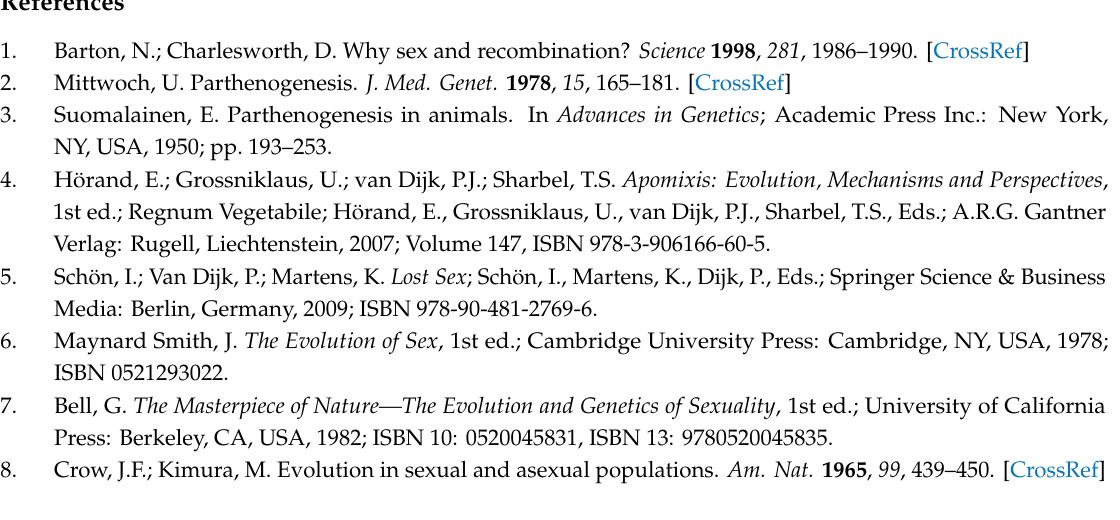
Figure S1: Images of ovule staging (I, II, III, IV). The bar represents 100 µ m, Figure S2: Change in expression patter according to the Short Time-series Expression Miner (STEM) program, Figure S3: Expression pattern changes in di ff erentially expressed genes, Table S1: Blast2Go ontology for di ff erentially expressed genes across stages, Table S2: SNPs Contig 368515, Table S3: Genes showing similar 2x-6x expression pattern and 4x parent of origin e ff ects, Table S4: Normalized gene expression data of four ovule developmental stages used in Figure 3. A: stage I; B: stage II; C: stage III; D: stage IV. Rows correspond to gene IDs and columns to microarray chips, Table S5: Blast2go p1p2hyb e ff ect, Table S6: List of Genes and primer used for microarray